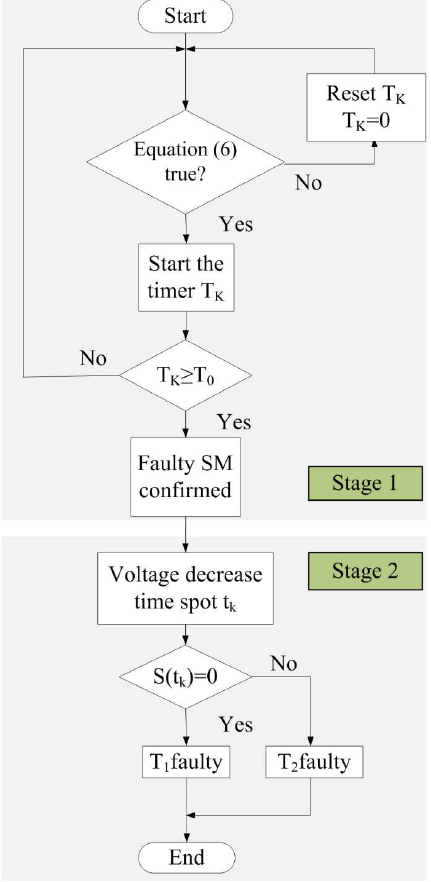
Figure 7. Flowchart of the short-circuit fault detection and location method.